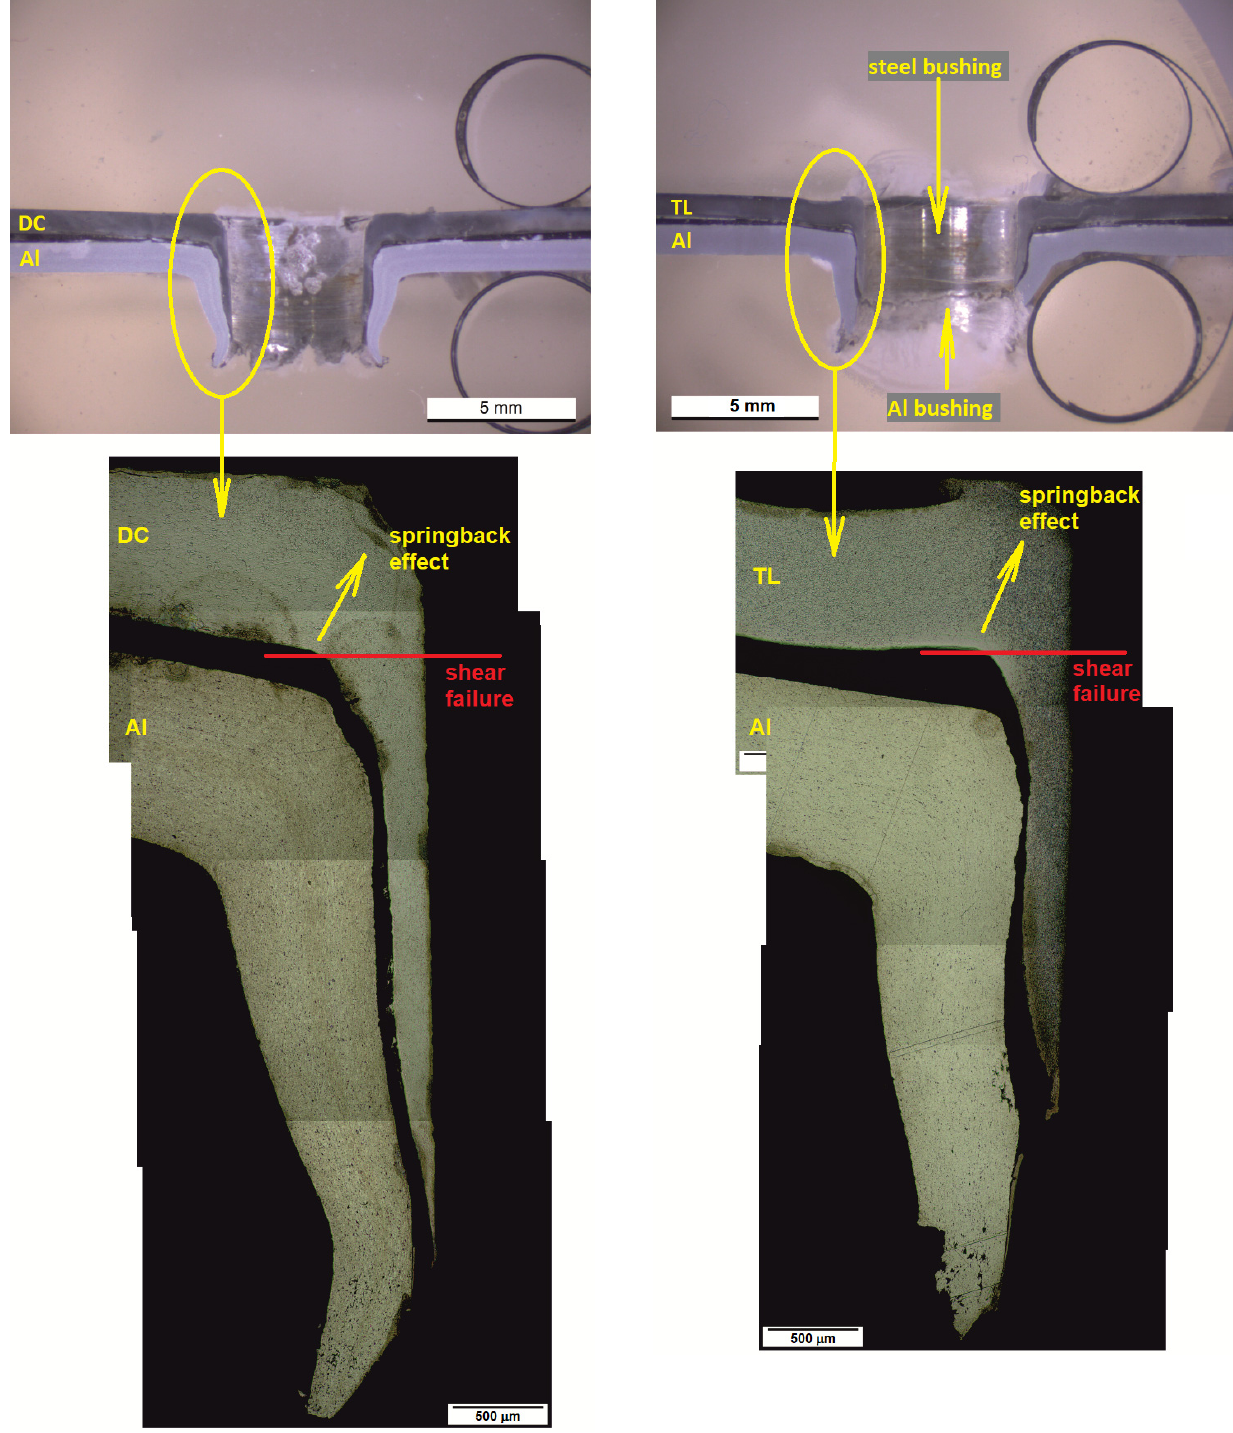
Figure 3. Cross sections of DC-Al and TL-Al joints, etched: Nital, HF.